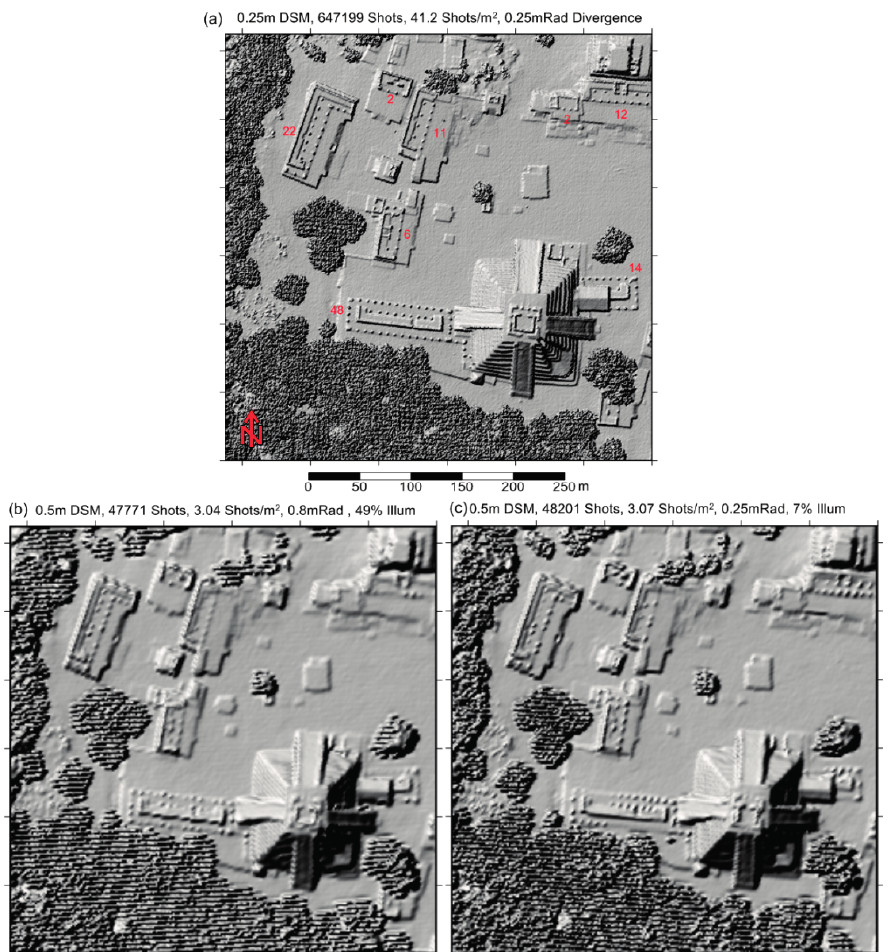
Figure 12. Relationship between laser beam footprint/surface illumination and target detection probability. ( a ) Reference high resolution (0.25 m DSM), red numbers indicate the number of columns that were identified and used for the test; ( b ) 0.5 m DSM from ALS data collected with 0.8 mrad divergence; ( c ) 0.5 m DSM from ALS data collected with 0.25 mrad